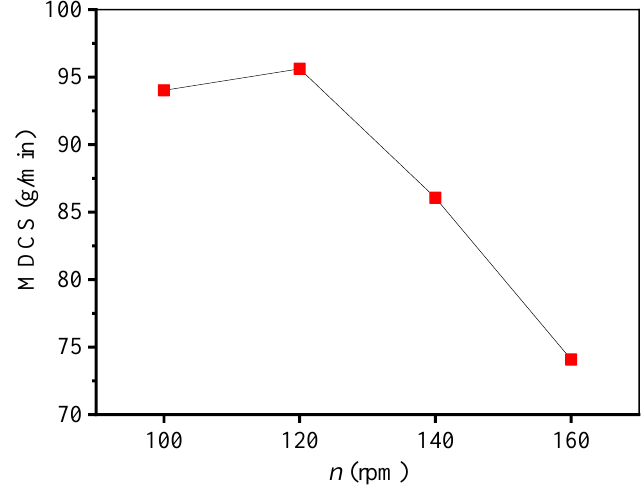
Figure 15. Influence of SMH drill pipe rotary speed on MDCS.